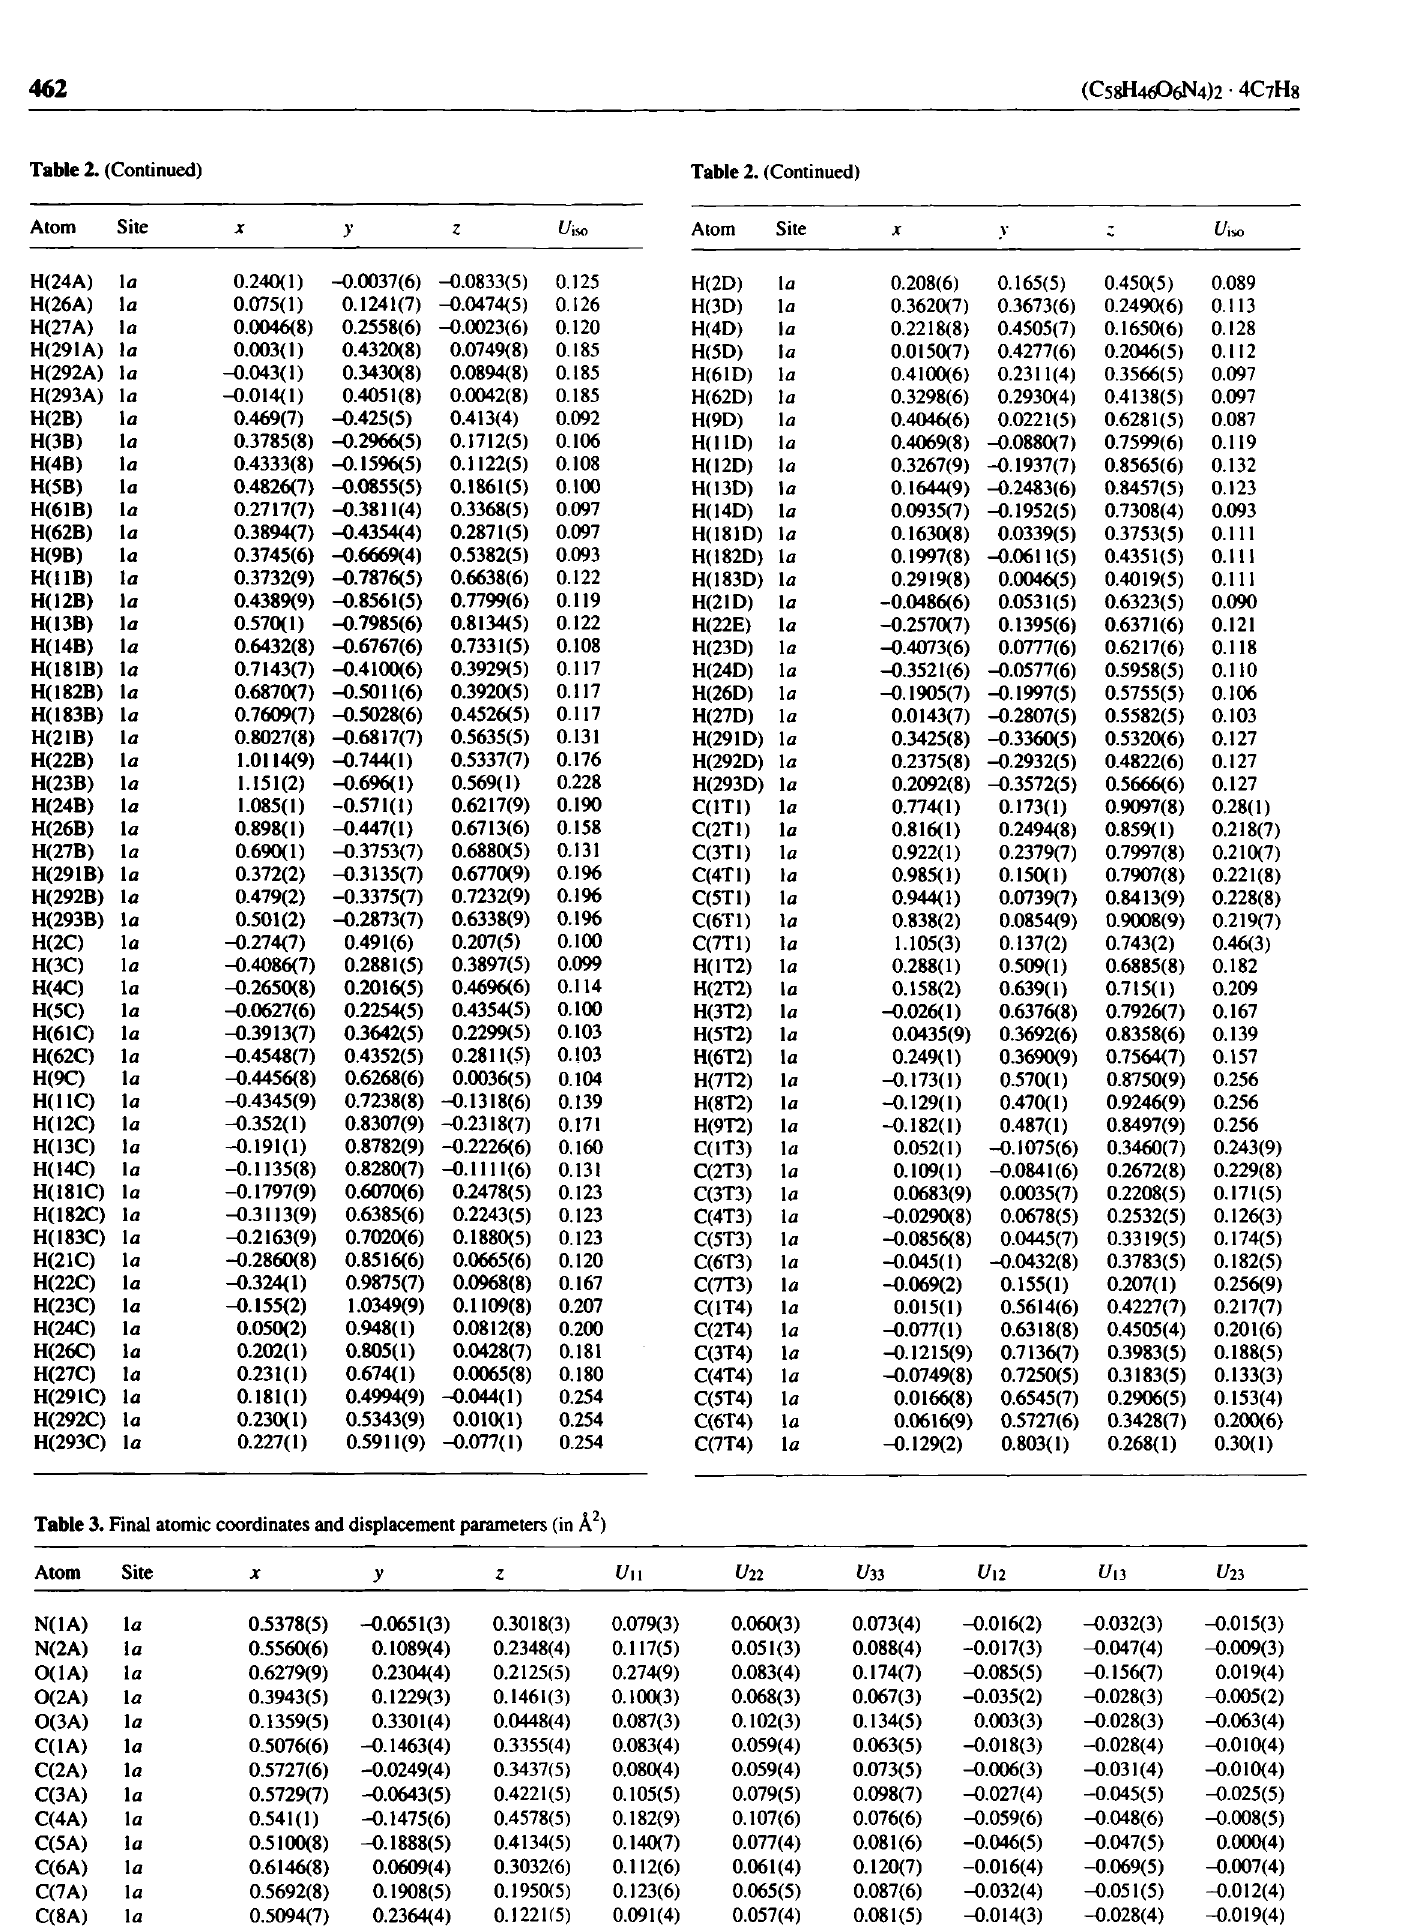
Table 3. Final atomic coordinates and displacement parameters (in A 2